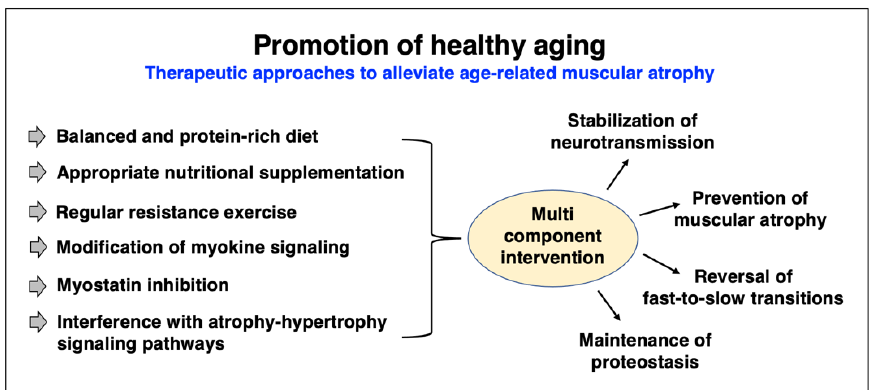
Figure 6. Overview of therapeutic approaches to counteract age-related muscular atrophy.